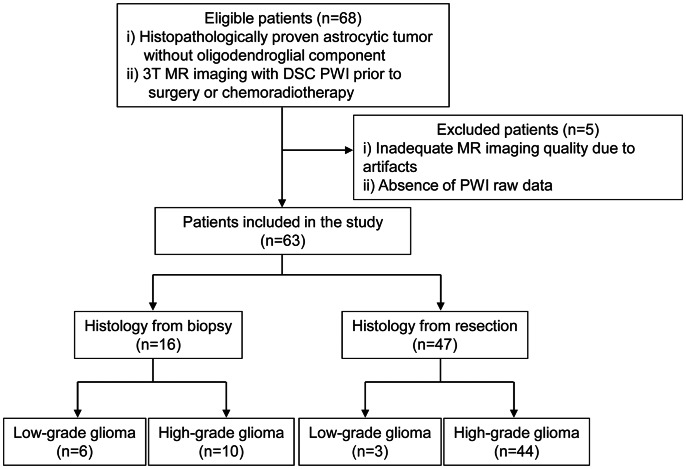
Flow diagram of patient selection and inclusion and exclusion criteria.DWI = diffusion-weighted imaging; DSC = dynamic susceptibility contrast; PWI = perfusion-weighted imaging.